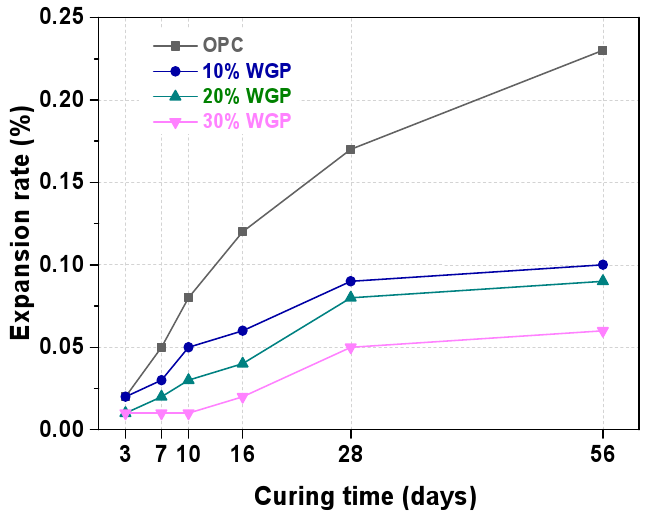
Figure 5. Expansion rate of ASR of mortars with WGP substituting 0%, 10%, 20%, and 30% of Portland cement.